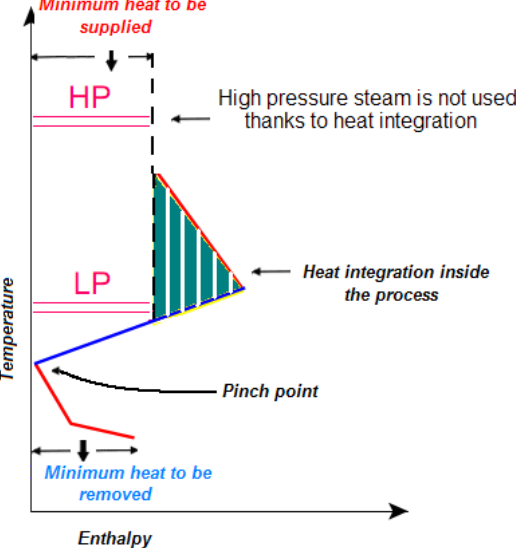
Figure 3. Process integration makes it possible to use low pressure steam